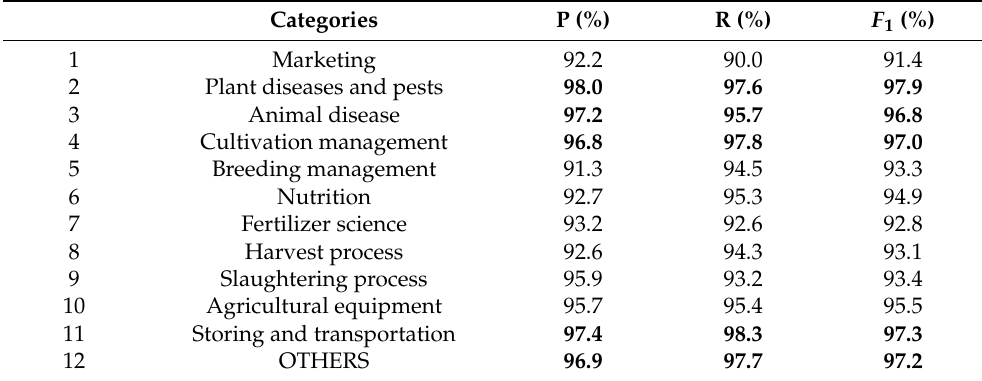
Table 8. Evaluation of our model in different categories.